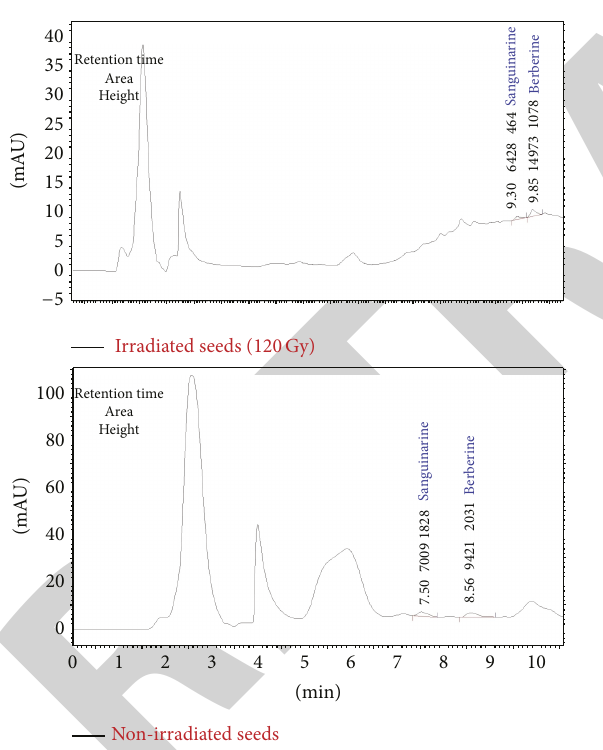
Figure 3: HPLC chromatograms of control and 𝛾 -irradiated seeds (120Gy) according to standard mixture. Retention time has been adjusted based on the centesimal unit in this